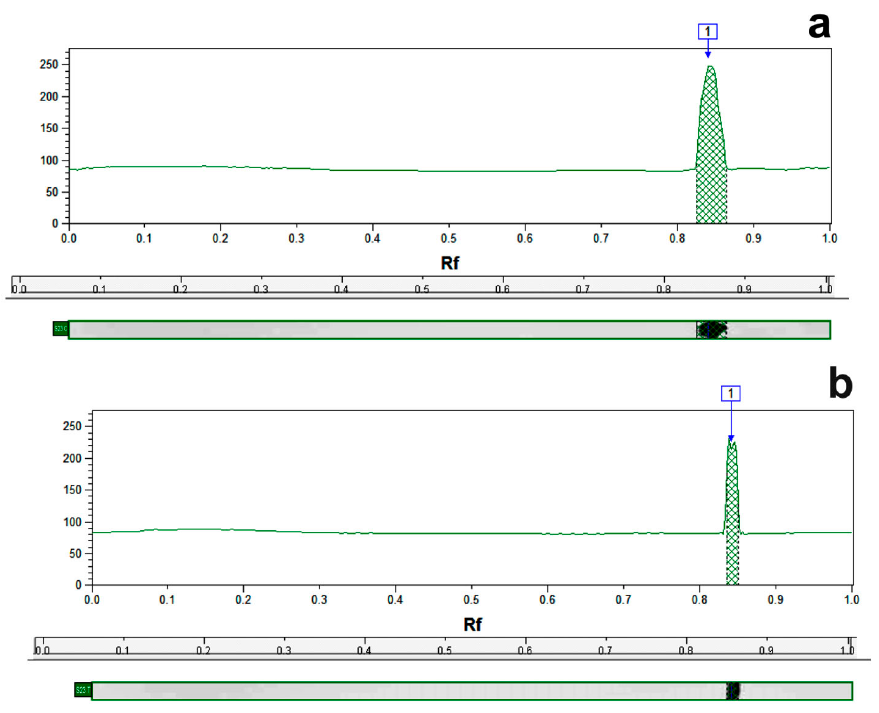
Fig. 6 . Representative dendogram showing the densitometric intensity computerized analysis of SdrM efflux pump protein in MRSA isolate S23 control (a) and treated sample with 16µg/ml of caspofungin